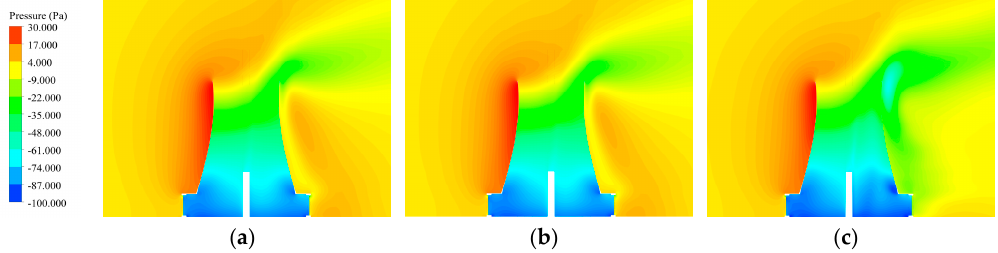
Figure 9. Comparisons of pressure distribution at vertical plane (y = 0 m) in NDDCT with flue gas injection: ( a ) RANS; ( b ) URANS; ( c ) LES.